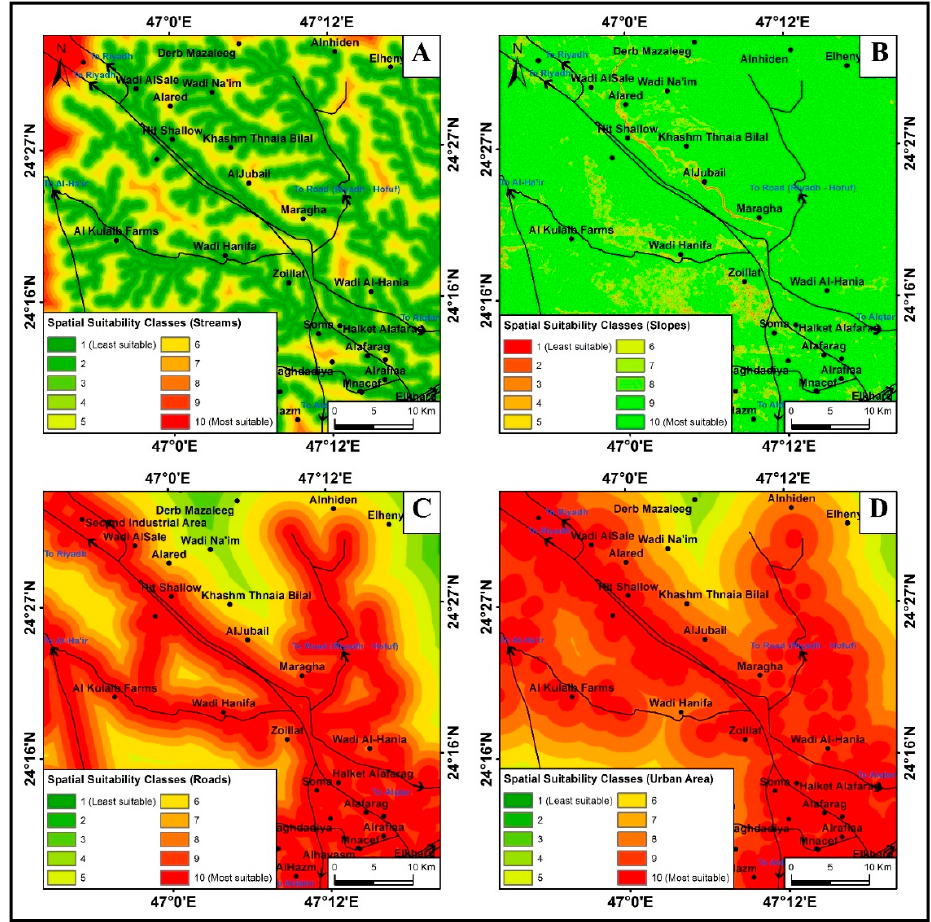
Figure 9. The spatial suitability (part 1) of ( A ) streams / valleys, ( B ) earth surface slopes, ( C ) road networks, ( D ) urban areas.